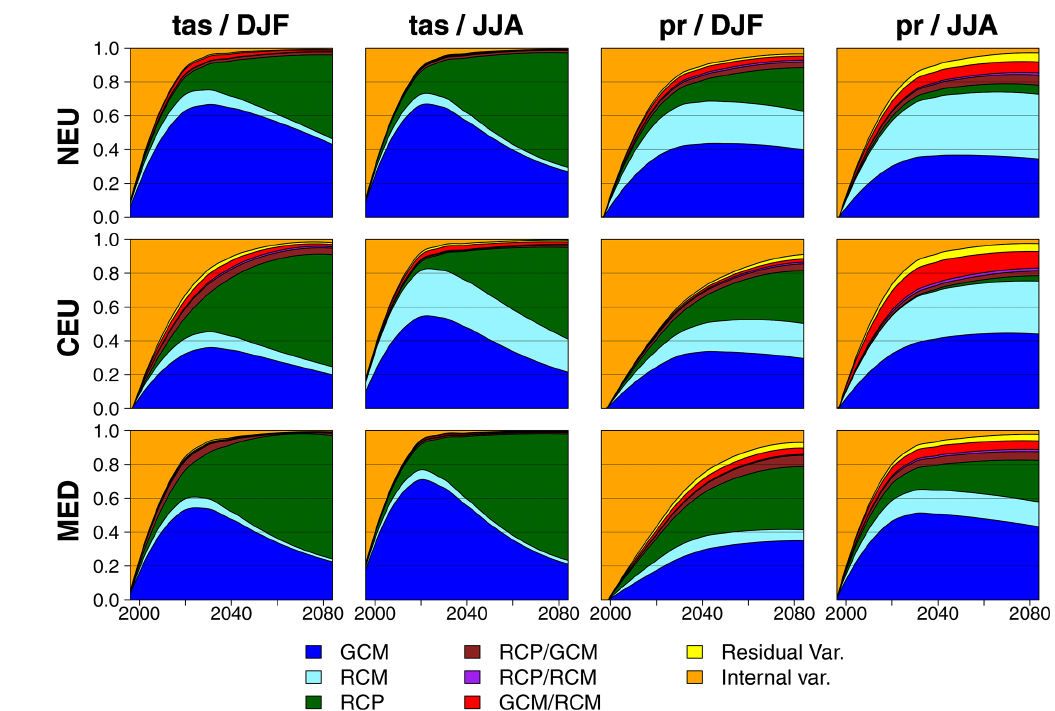
Figure 3. Fraction of total variance for absolute changes in mean temperature (tas) and relative changes in total precipitation (pr) in winter (DJF) and summer (JJA) as a function of time compared to the period 1981–2010 for three illustrative regions (see Fig.